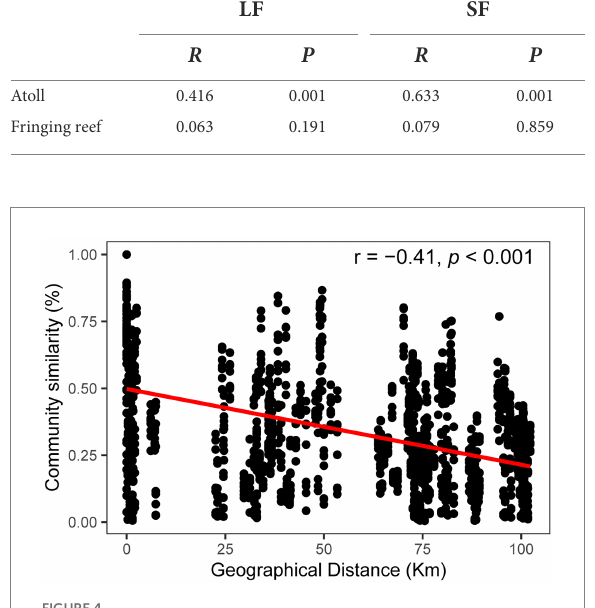
FIGURE 4 Distance-decay patterns based on the Bray–Curtis similarity for the bacterial